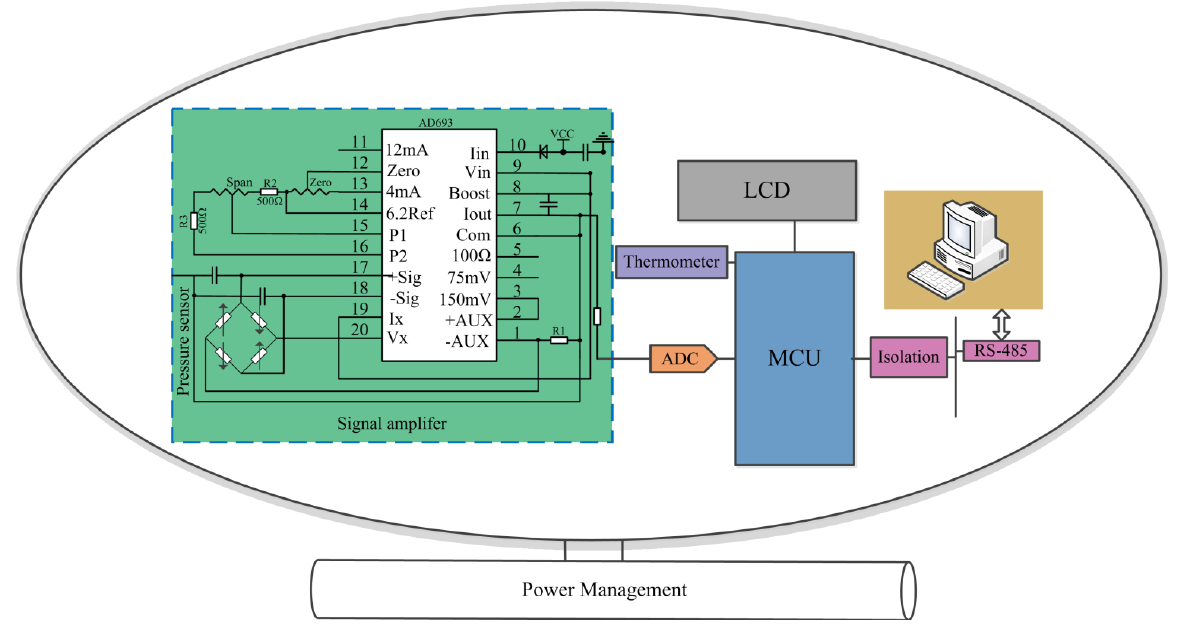
Figure 4. Schematic of system